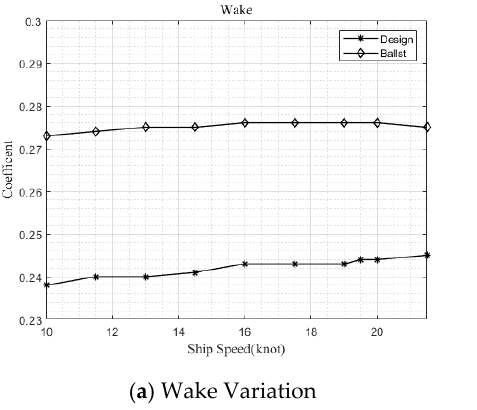
Figure 5. Wake and thrust deduction variation.